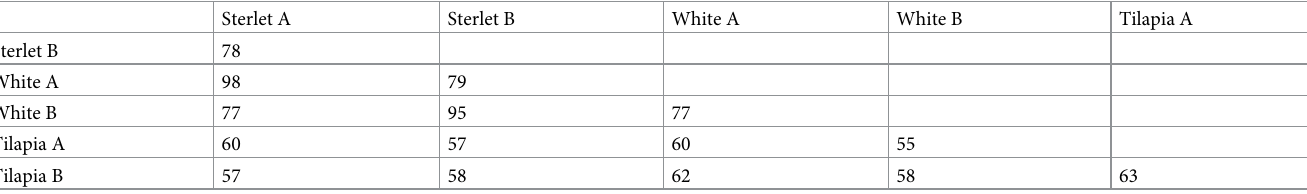
Table 2. Percent identities in TGM1 sequences generated from two-way comparisons using NCBI Protein BLAST. Sterlet A Sterlet B White A White B Tilapia A Sterlet B White A 79 White B Tilapia